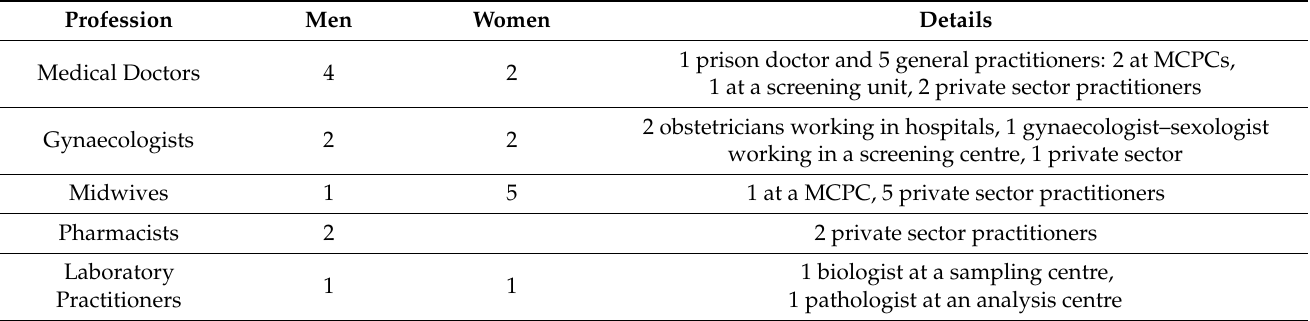
Table 2. Health Professional Participants.